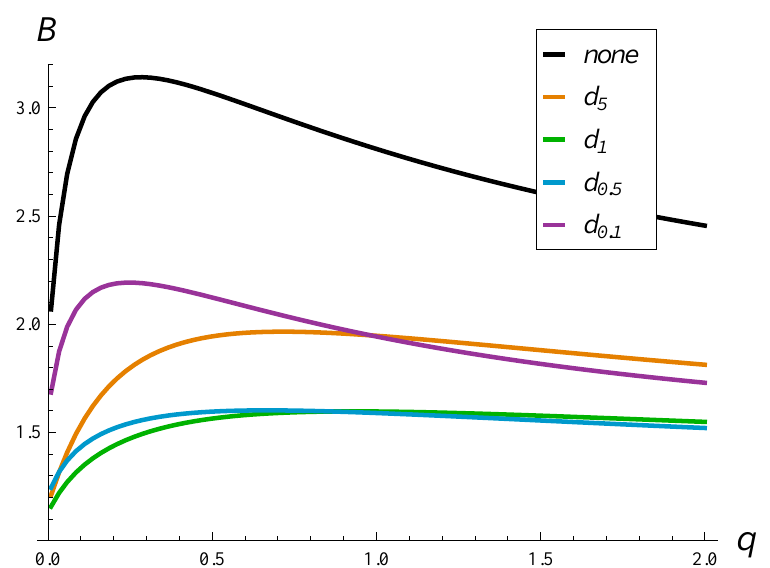
Figure 3. Burst ratio vs. the autocorrelation strength for a few functions d ( n ) and no AQM. Link load ρ =